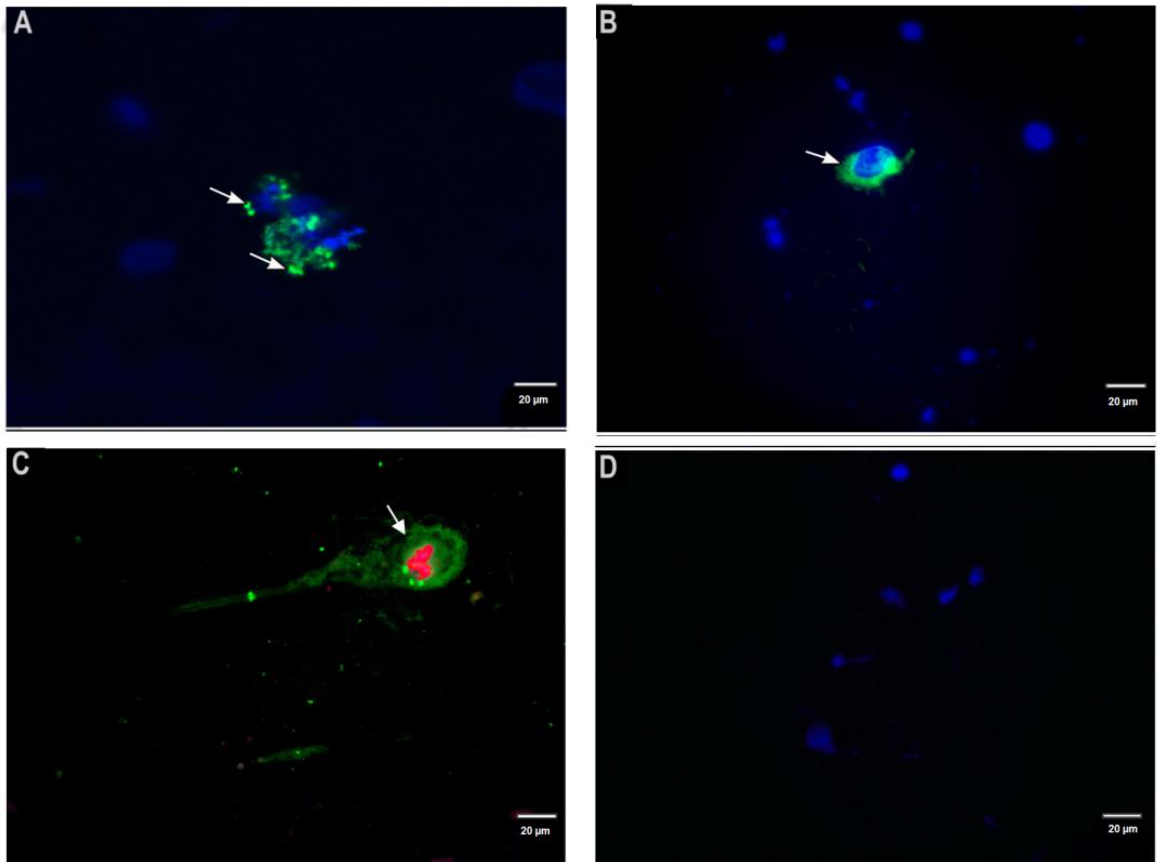
Figure 2. Detection of L. major infected cells and L. major amastigotes on fixed dermal scrapings slides by direct immunofluorescence assay. ( A ): The slide was observed by confocal microscopy at objective × 40. Fluorescent amastigotes (green) (arrow) were clearly shown inside host cells, which were recognized by their nucleus stained in blue by DAPI. ( B ): The slide was observed by epifluorescence microscopy at objective × 40. Leishmania antigen (arrow) appears as a diffuse deposit in the cytoplasm of mononuclear phagocytic cells, which were recognized by their nucleus stained in blue by DAPI. ( C ): The slide was observed by epifluorescence microscopy at objective × 40. The DIF assay was performed without DAPI. Leishmania antigen appears as a diffuse deposit inside the host cell (arrow), which also harbors Leishmania amastigotes. ( D ): The dermal scraping of suspected CL lesion with both negative microscopic examination and qPCR did not show fluorescence. Nuclear cells are clearly observed with DAPI.